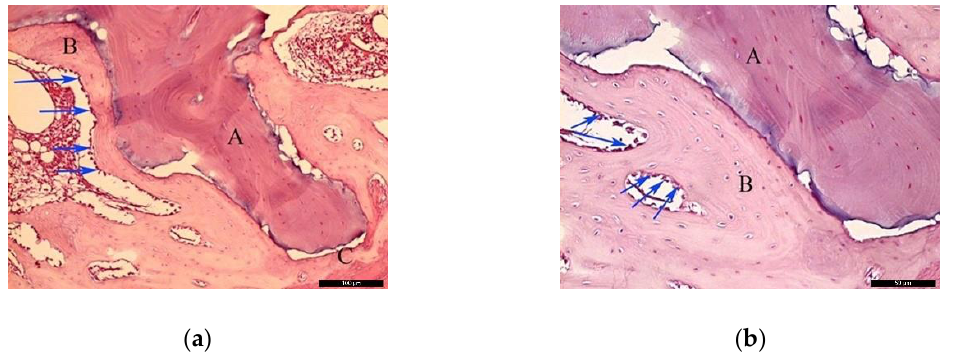
Figure 5. Histological analysis of the biomaterial group (BG) at 30 days. ( a ) Biomaterial (A) in close contact with the newly formed bone (B), and the residual recipient site (C); osteoblast-like lining cells are indicated with blue arrows. Hematoxylin and eosin stain at a magnification 40×; ( b ) Biomaterial (A), newly formed bone (B), and lining osteoblast cells in the periphery of the newly formed bone (blue arrows). Hematoxylin and eosin stain at a magnification 125×.